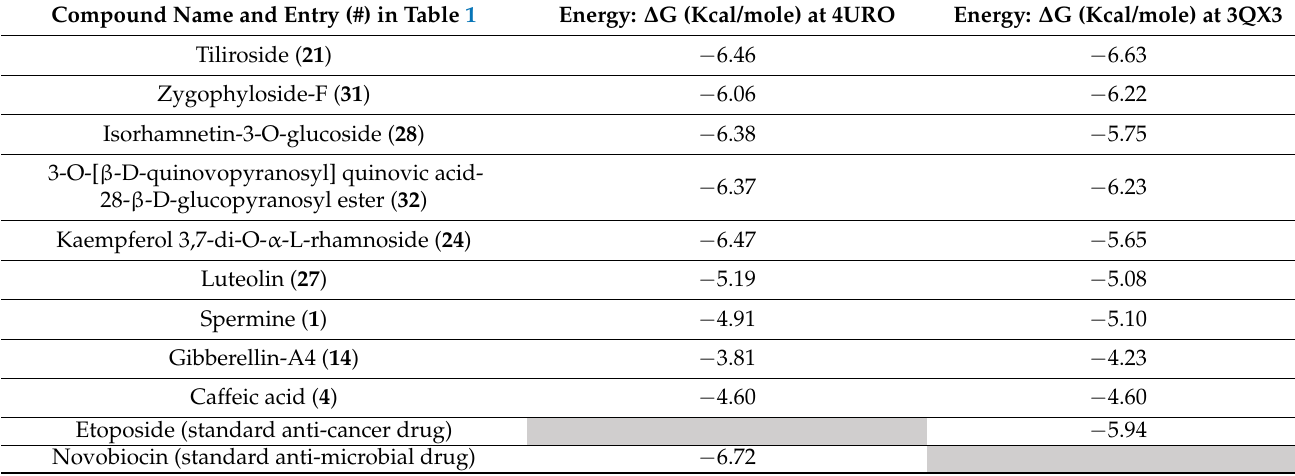
Table 4. Z. coccineum major constituents’ relative abundance in plant extract, and their in silico binding interaction energies. Compound Name and Entry (#) in Table